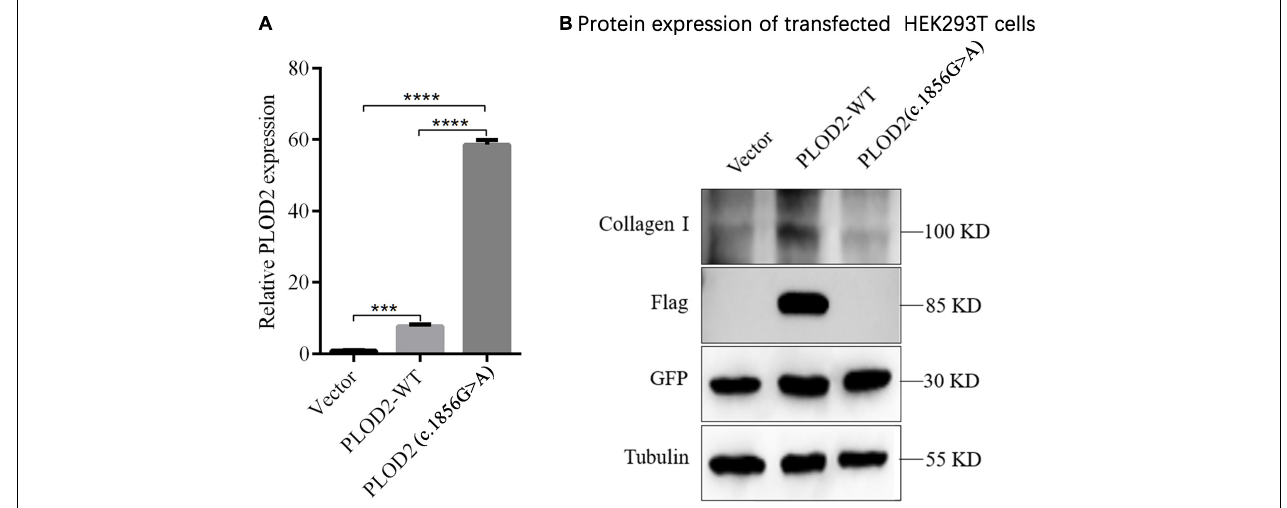
FIGURE 4 | Expression analysis of PLOD2 in HEK293T cells. (A) RT-qPCR detection showed that c.1856G > A variant caused significant overexpression of PLOD2 gene compared with the empty type (Vector) and wild type ( PLOD2 -WT) groups, *** p < 0.001, **** p < 0.0001. (B) Using anti-Flag antibody against Flag-labeled PLOD2, the expression of Flag-PLOD2 and Collagen I protein in Vector, PLOD2-WT, and PLOD2 - c.1856G > A in HEK293T cell lysate was detected by Western